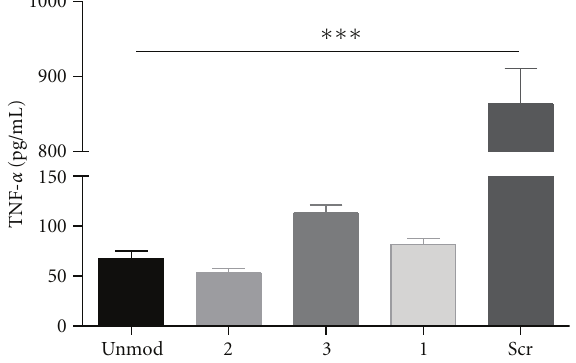
Figure 6: Inhibitory capacity of branched anti-TNF- α siRNAs. The inhibitory capacity of the siRNA duplexes are expressed as double strand concentration for comparative purposes. A 100-nM double strand concentration is equivalent to a concentration of 100nM of unmodified siRNA duplex, 50nM of siRNA 1 , and 2 and 25nM of siRNA 3 . Transfection of siRNAs was carried out using oligofectamine. Values are represented as the average ± ES, n = 3 and are compared to a scrambled sequence. ∗∗∗ P < . 001, ANOVA Test, Bonferroni